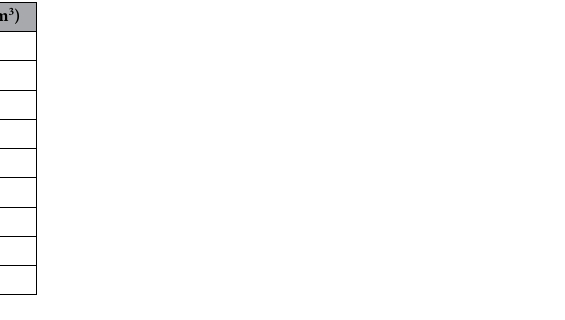
Table 2. Parameters of pullout test samples.